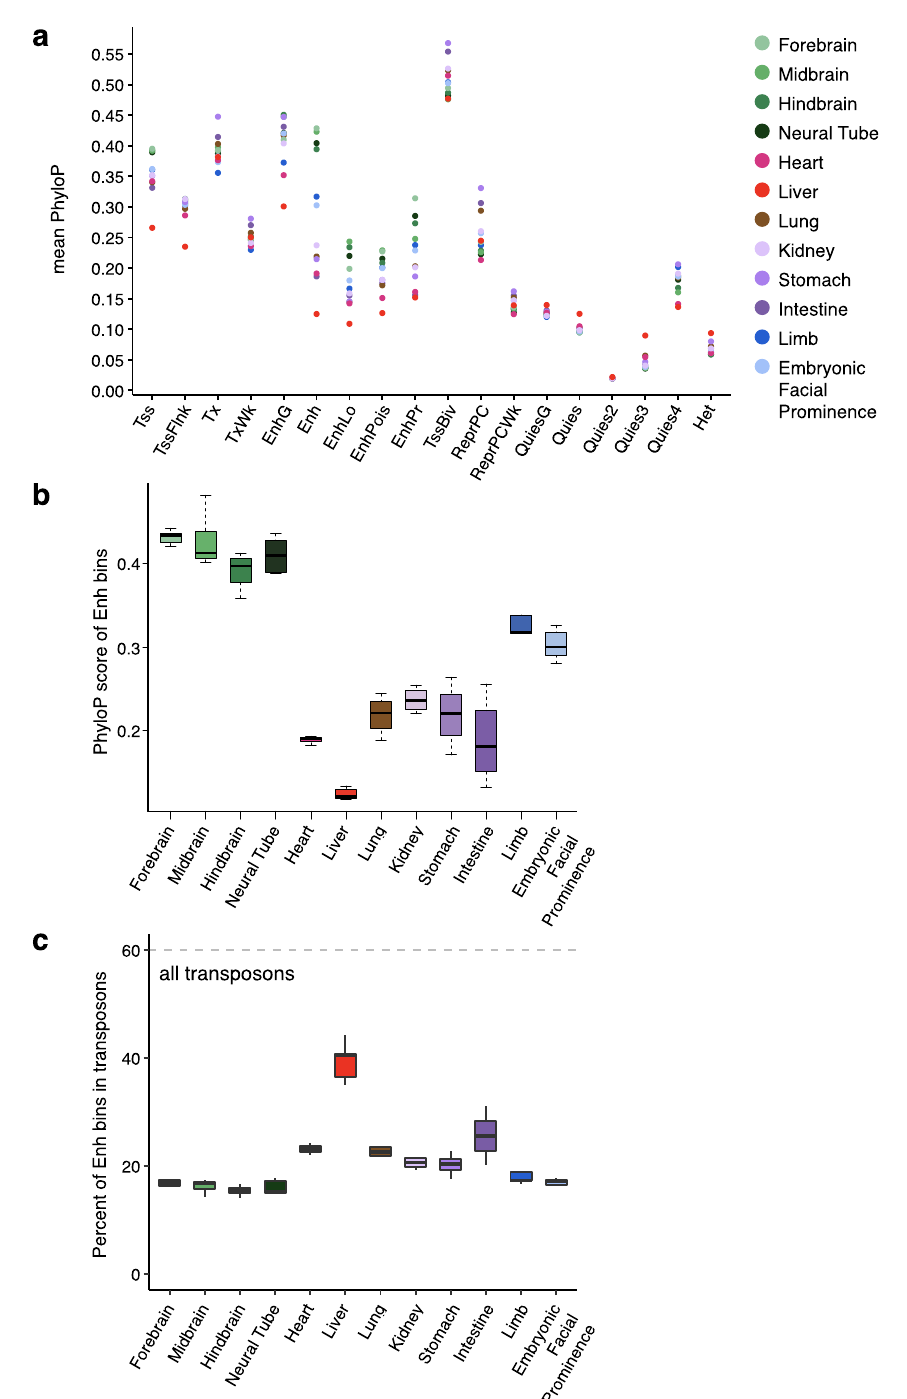
Fig. 5 Evolutionary conservation of genomic regions by chromatin state. a The PhyloP conservation score (phyloP60way for mm10) for genomic regions assigned to each chromatin state. Colors correspond to tissues. b PhyloP score for genomic bins assigned to Enh in all 12 tissues. c Percentage of bins assigned to Enh that overlap with transposons, for all 12